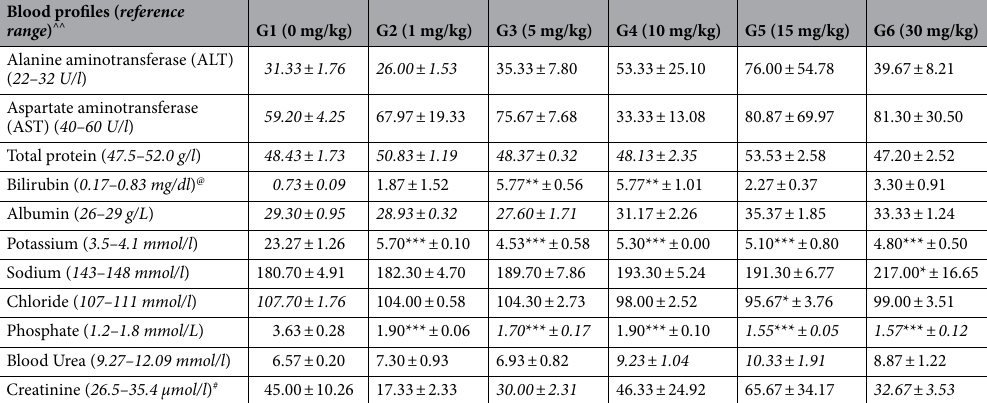
Table 2. Biochemical blood analysis. ^^ these reference intervals for clinical biochemistry profiles were obtained from P90-P135 (n = 1486) C57BL/6 and C3HeB/FeJ female mice 31 , with exception to the profile labelled with @ , which were obtained from 8-, 26- and 52-week old (n = 4, 7 and 8 per age group, respectively) C57BL/6 female mice 32 , whereas the profile labelled with # were obtained from inbred (n = 10) and outbred (n = 30) 4-week old female mice 33 . Italic readings are within the reference intervals. All values represent in mean ± SEM. * Denotes adjusted p < 0.05, ** denotes adjusted p < 0.01 and *** denotes adjusted p < 0.001 when compared to G1 (0 mg/kg) group (n = 3 per group, based on One-way ANOVA with Dunnett’s multiple